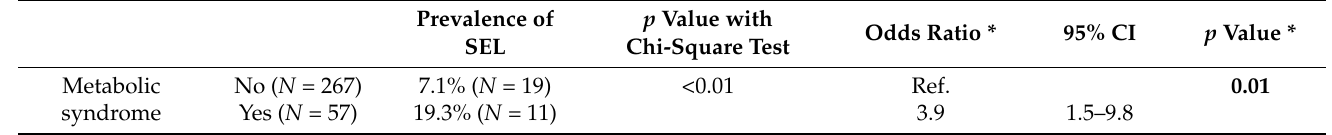
Figure 2. Cross-sectional area of epidural fat (EF) * and the spinal canal **. From Ishihara et al. (2019), with permission. Table 2. Association of metabolic syndrome with